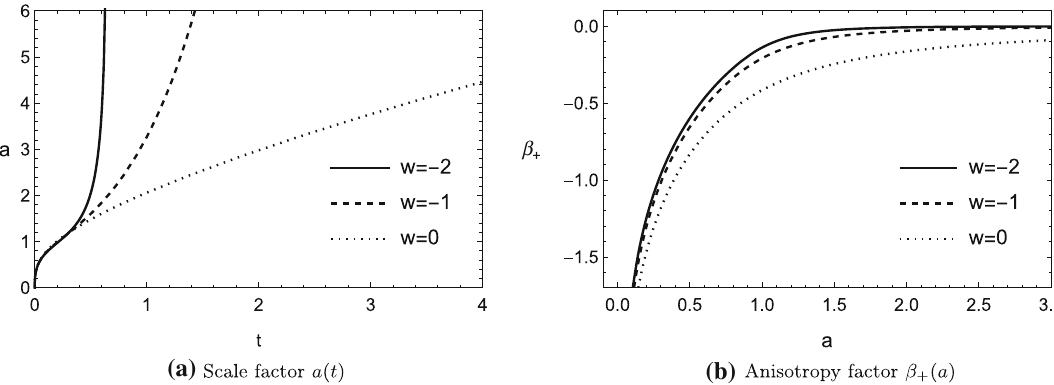
Fig. 2 Scale factor a ( t ) and anisotropy factor β + ( a ) for different w and p + = p − = V 0 = 1. One recognizes isotropization for large